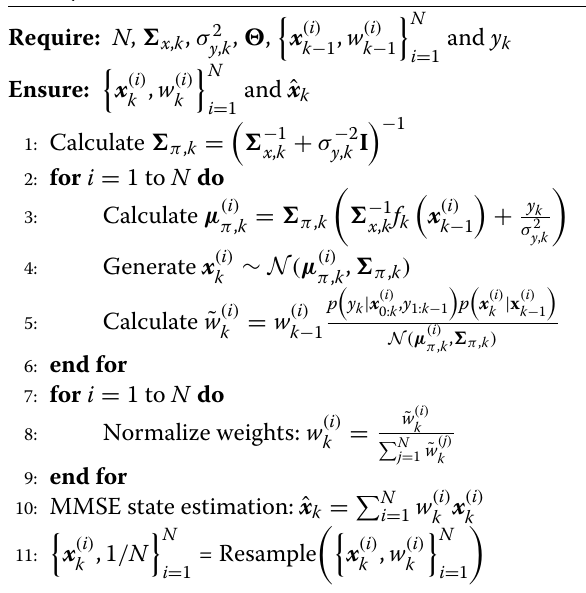
Algorithm 1 Particle filtering with optimal importance